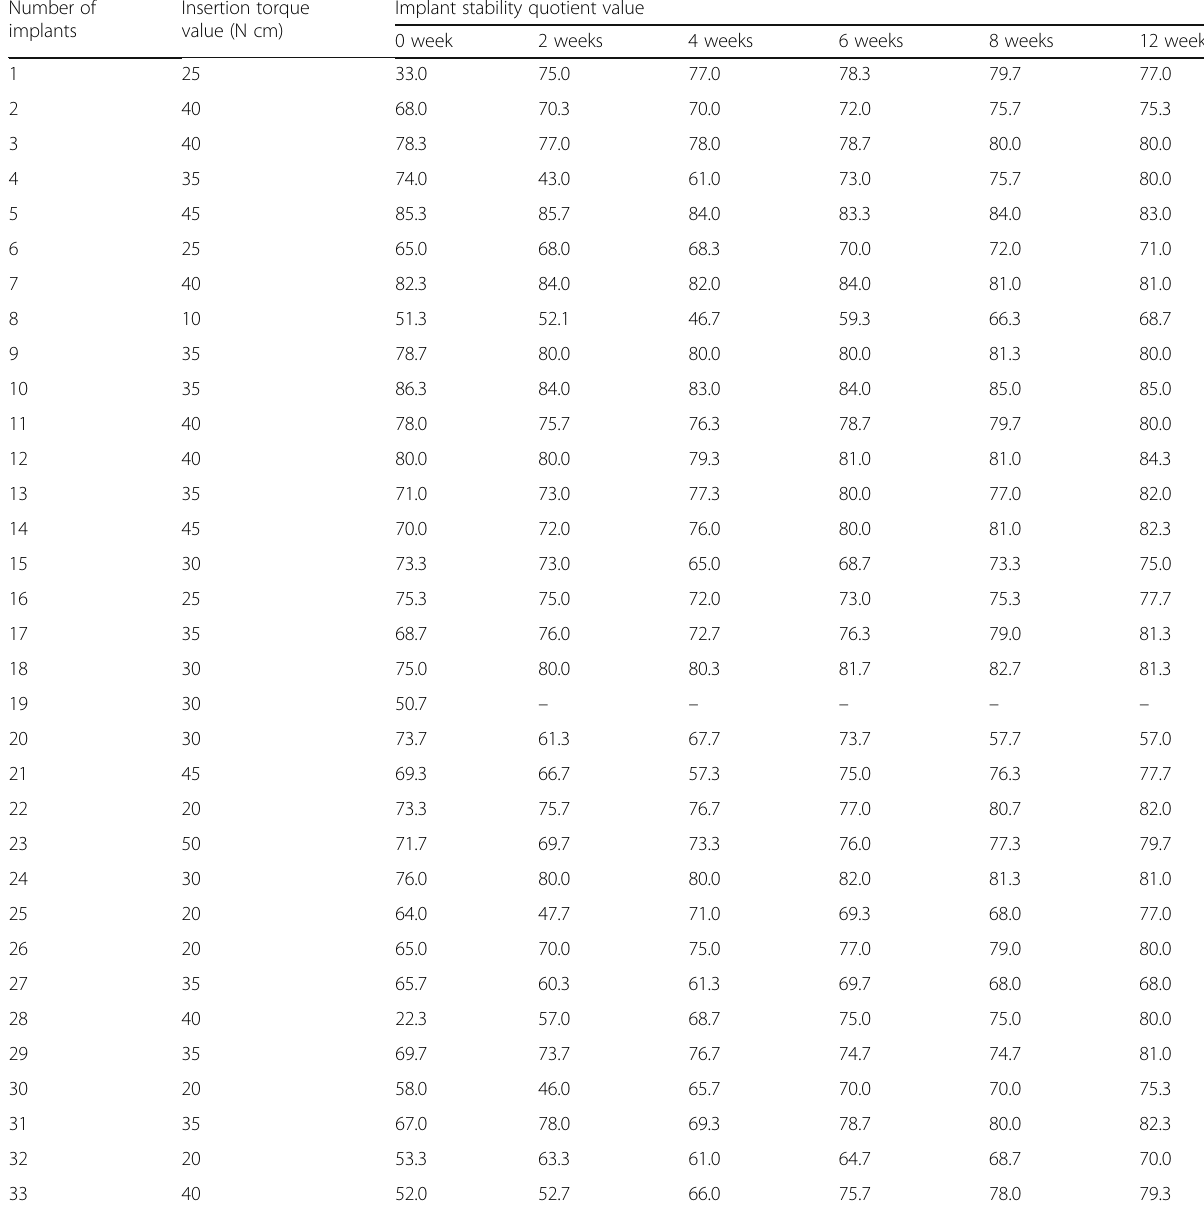
Implant stability quotient